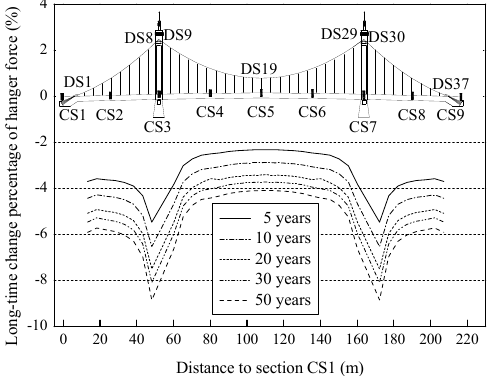
Figure 15. Predicted change percentages of hanger forces.